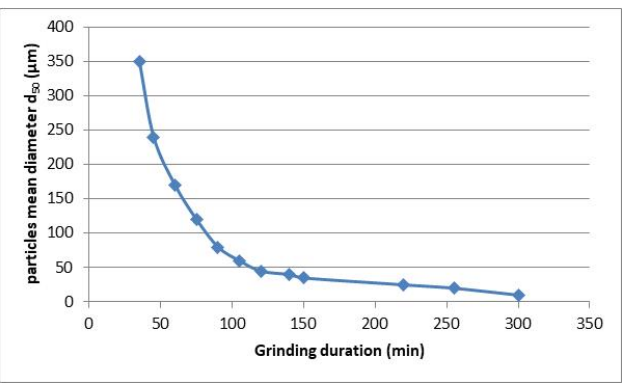
Figure 2. Evolution of the size of the glass particles as a function of the grinding duration of 20 kg of glass waste inside the bar mill.